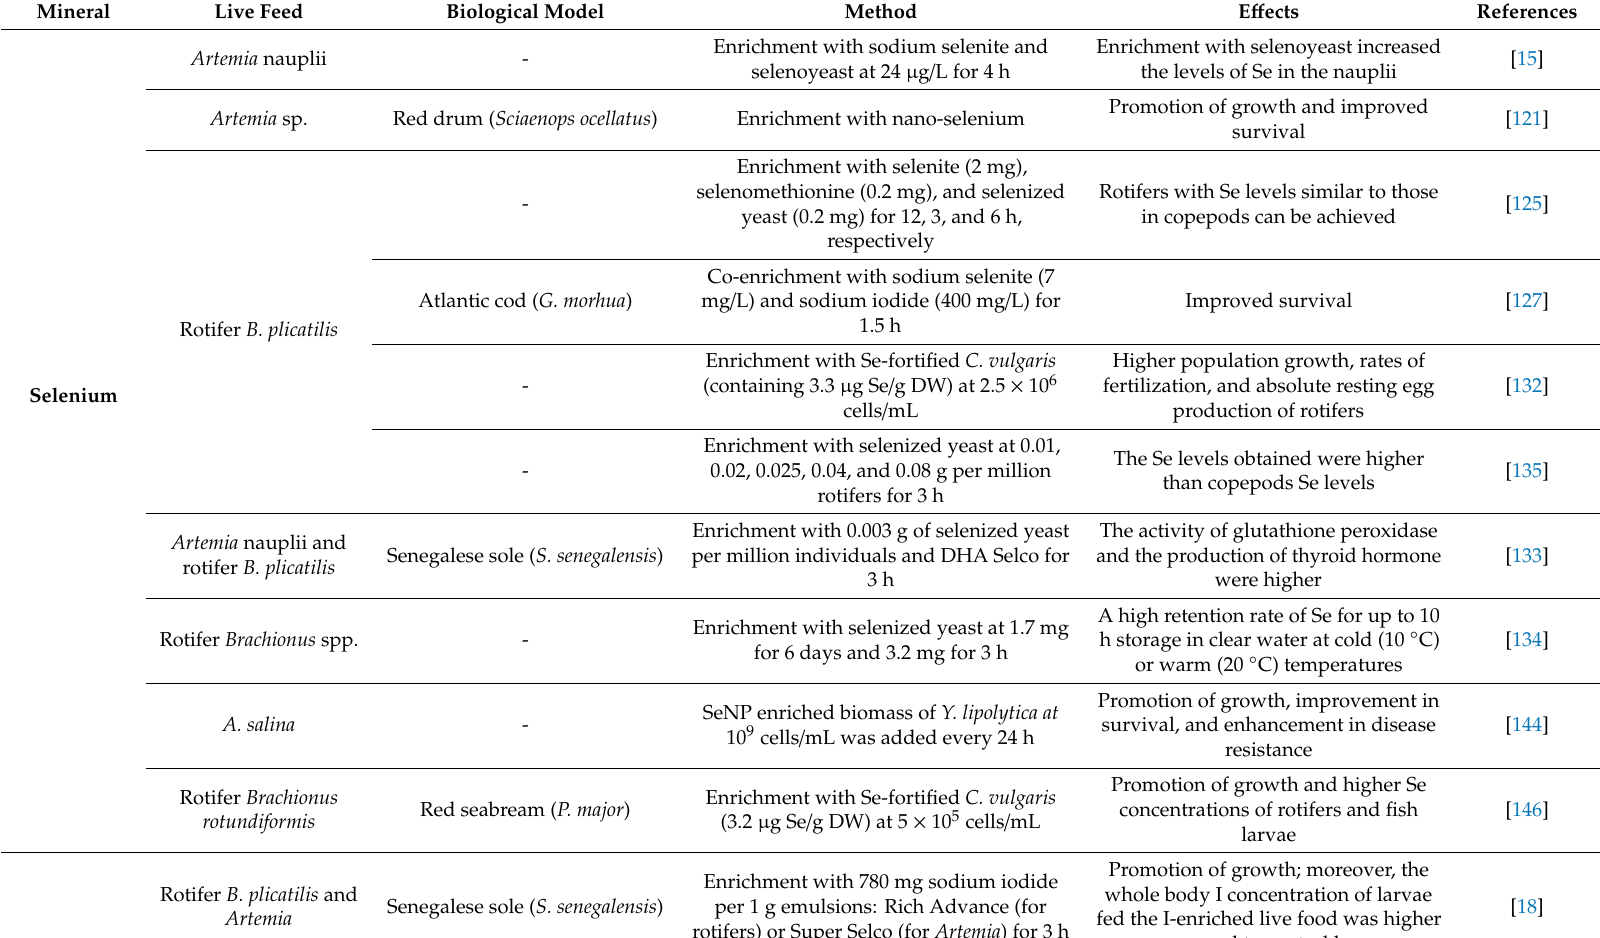
Table 2. Enrichment of live food with